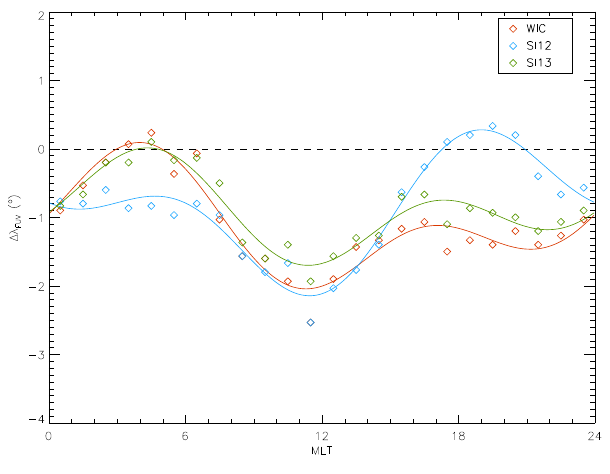
Fig. 9. Correction offset values for PALBs derived from images from the IMAGE FUV WIC, SI12, and SI13 detectors using the method outlined in this paper between May 2000 and August 2002, represented by diamond symbols. The solid lines in each panel show the second-order harmonic fits to these offsets.